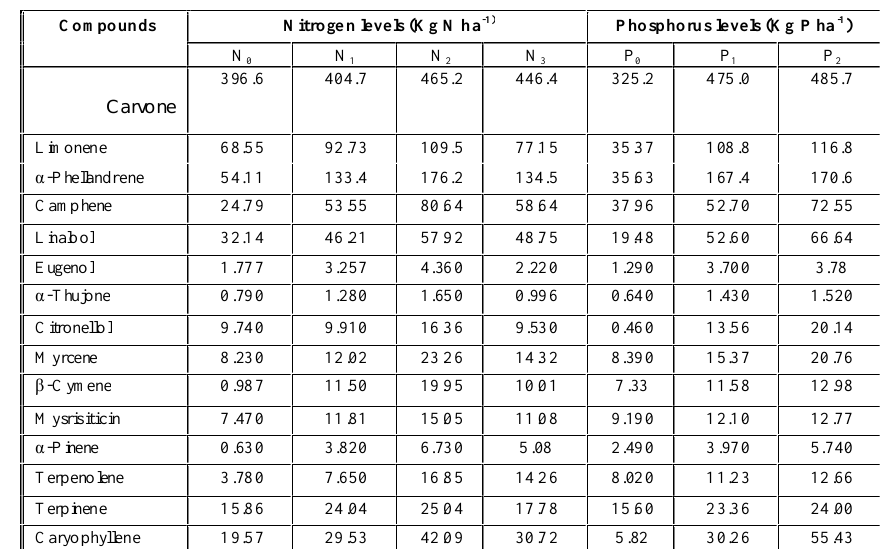
Table 2. Effect of nitrogen and phosphorus levels on dill seed oil constituents concentration (mg Kg seed -1